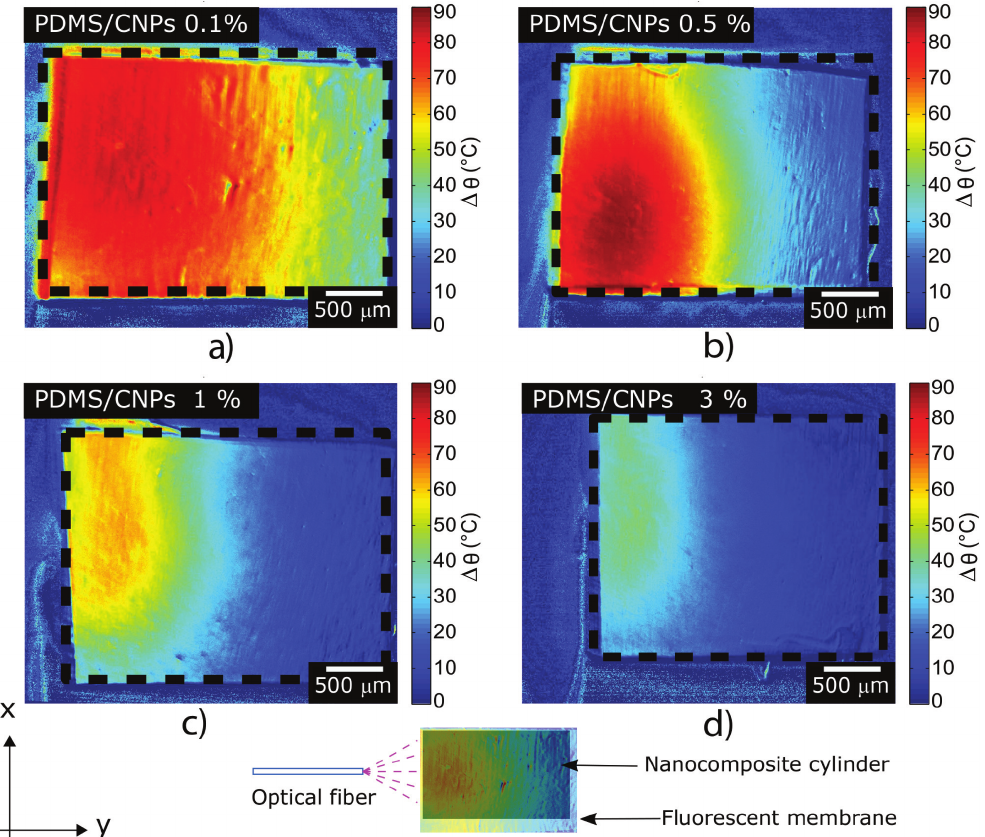
Figure 5. Temperature maps of the nanocomposites undergoing NIR irradiation obtained by LIFT; these figures depict the temperature distributions generated through the NIR absorption of the nanocomposites: ( a ) PDMS/CNPs 0.1% using d = 5 mm; ( b ) PDMS/CNPs 0.5% using d = 9 mm; ( c ) PDMS/CNPs 1% using d = 10 mm; and ( d ) PDMS/CNPs 3% using d = 16 mm. Video S1, in the Supplementary Material, shows the evolution of the heating